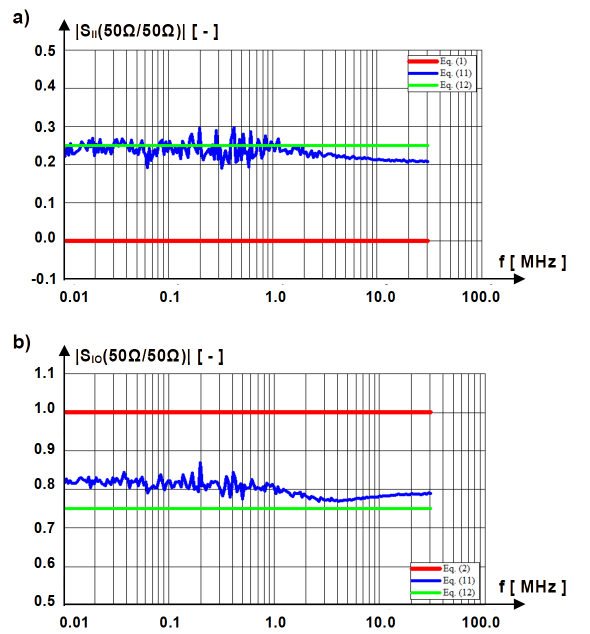
Figure 6. The parameters of the modal conversion of the common mode at the input to the common mode at the output: reflection ( a ) and transmission ( b ).